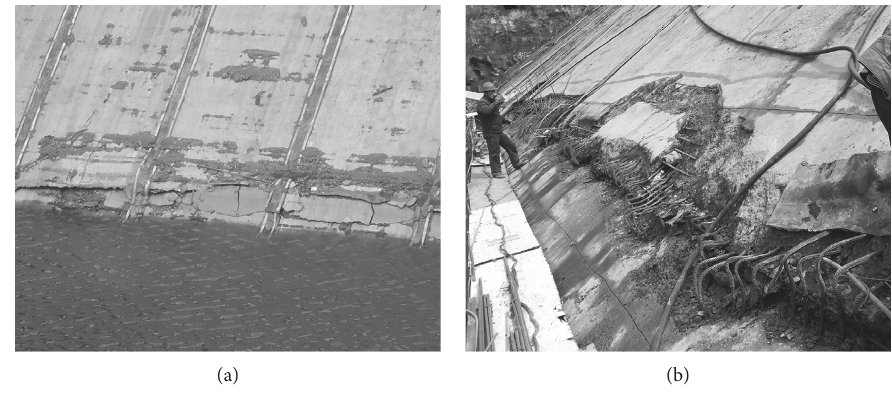
Figure 13: Local failure of the face in the phase I